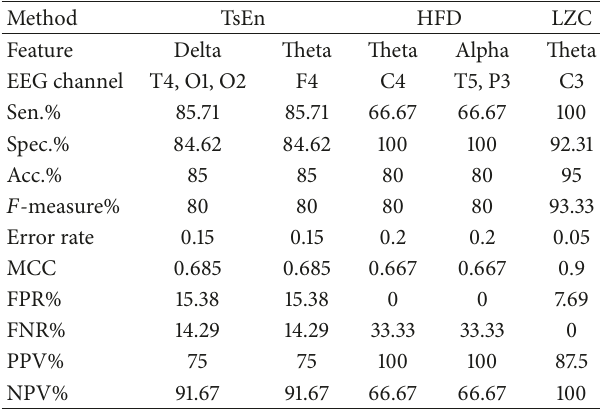
Table 3: Summary of the best performance indices for the three complexity